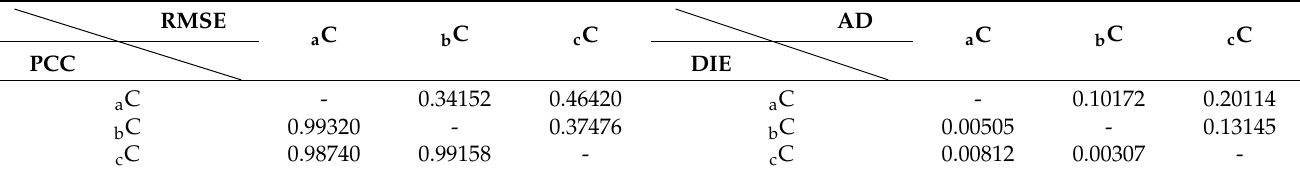
C , and c C for the data b